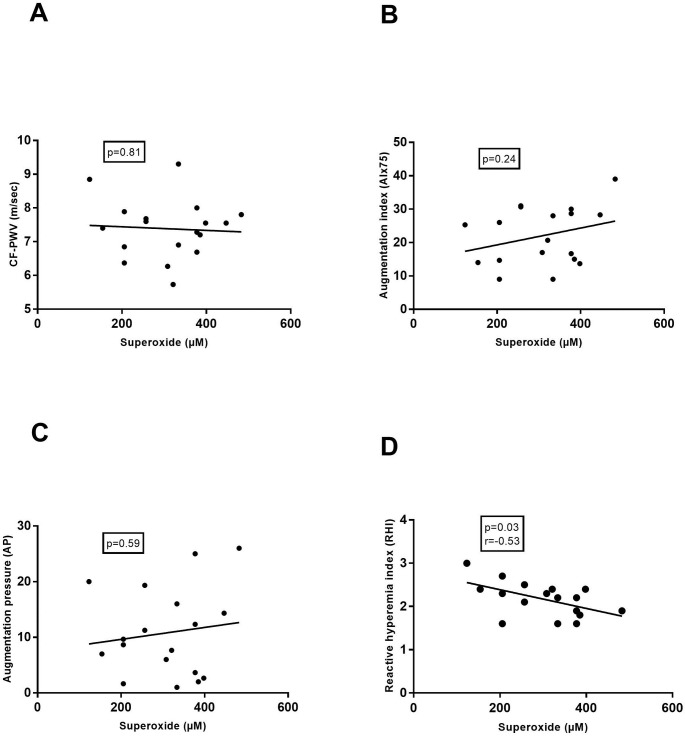
Correlation of superoxide concentrations with vascular function in preeclampsia.Vascular function was assessed by carotid-femoral pulse wave velocity (CF-PWV (7.6±0.9), Fig 2A), augmentation index 75 (AIx75 (24.0±9.6), Fig 2B), augmentation pressure (AP (11.8±7.8), Fig 2C) and reactive hyperaemia index (RHI (2.1±0.4), Fig 2D). (r: pearson correlation coefficient).